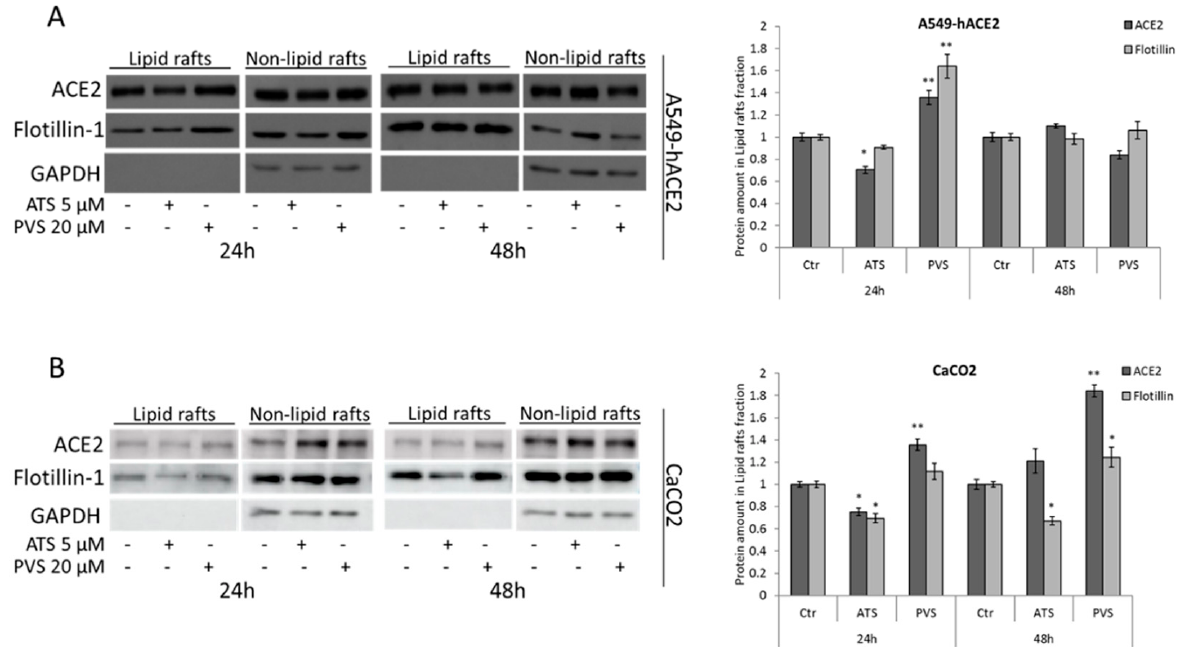
Figure 5. Representative Western blot analyses of ACE2 receptor and Flotillin-1 amount in lipid rafts and the complementary non-lipid rafts fractions, isolated from ( A ) A549-hACE2 and ( B ) CaCO2 cells, treated with ATS or PVS as indicated. Histograms on the right represent relative densitometric analyses of ACE2 receptor and Flotillin-1 in lipid raft fraction. GAPDH was used as loading control for the non-lipid rafts fraction. Data are expressed as mean ± SD of at least three independent experiments. * p < 0.05, ** p < 0.01 vs. control.